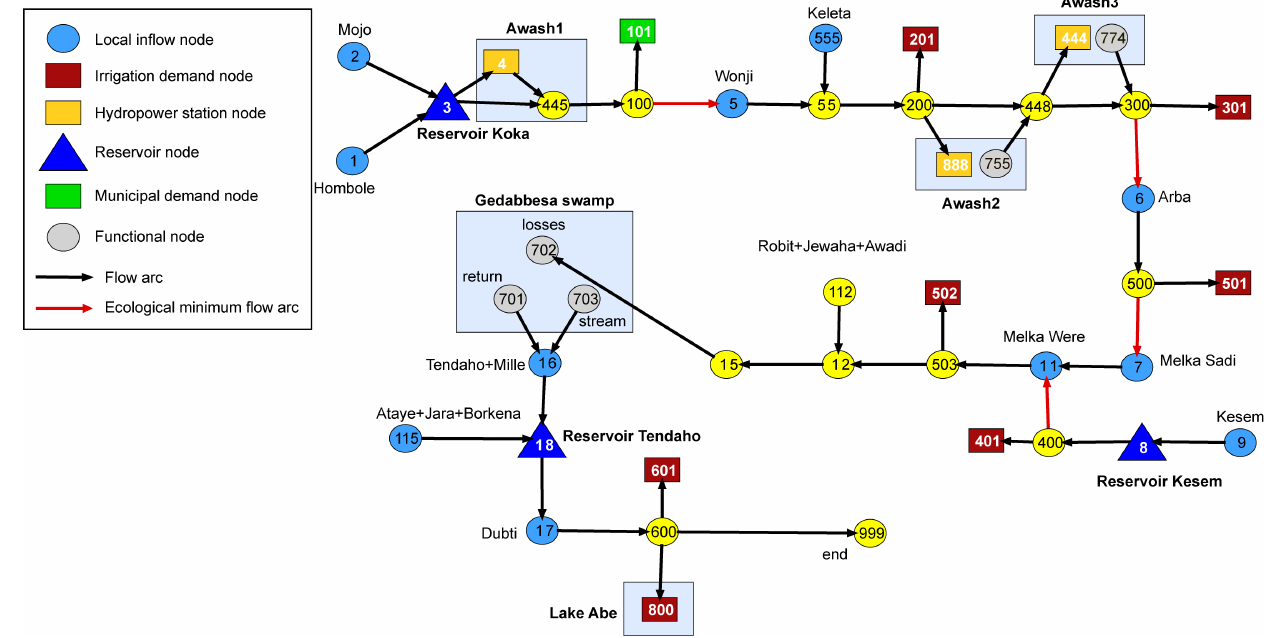
Figure 2. Schematic representation of Awash Basin multi-reservoir system in the modelling software